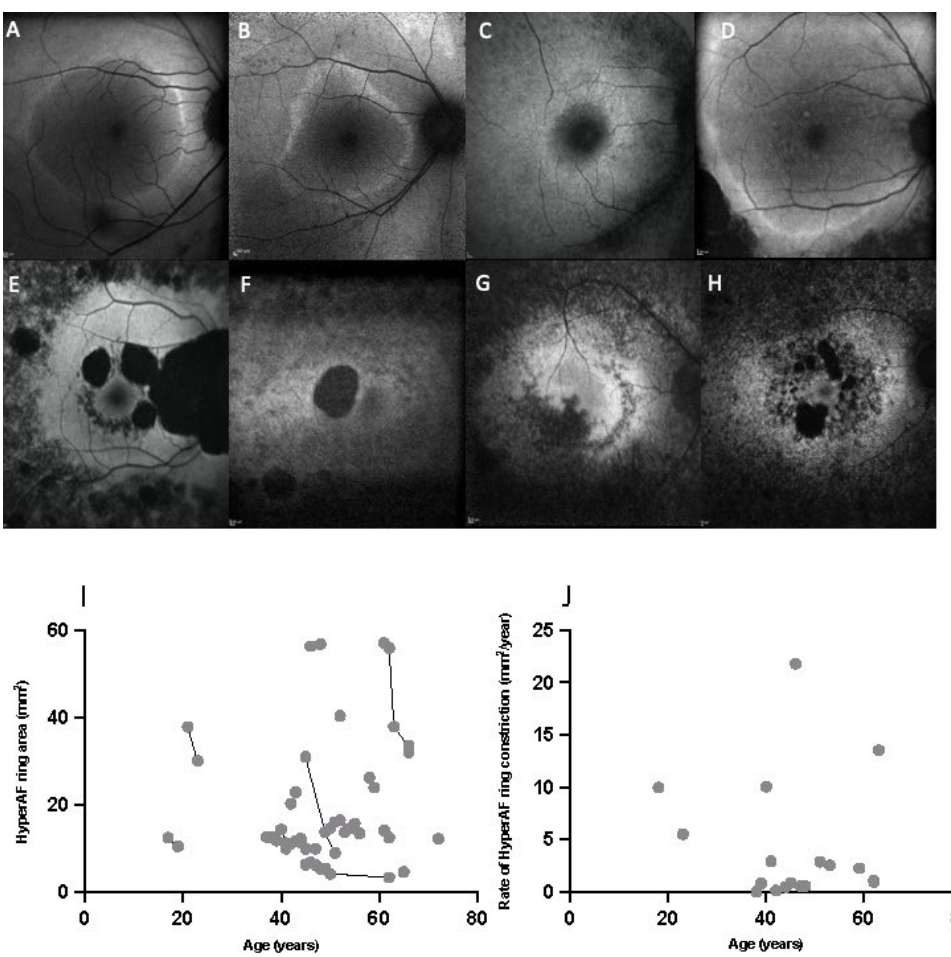
Figure 4. Fundus Autofluorescence (FAF) examples from patients with CNGB1-related retinitis pigmentosa. ( A – D ) show a hyperautofluorescent (hyperAF) outer ring phenotype, while ( E – H ) do not exhibit a measurable ring pattern. ( I , J ) show the quantification of the hyperAF outer ring area on FAF. ( I ) Correlation of hyperAF ring area as a function of age. ( J ) Correlation of rate of constriction of hyperAF area as a function of age, which was not statistically significant (r 2 = 0.012 p = 0.667) using Pearson correlation.